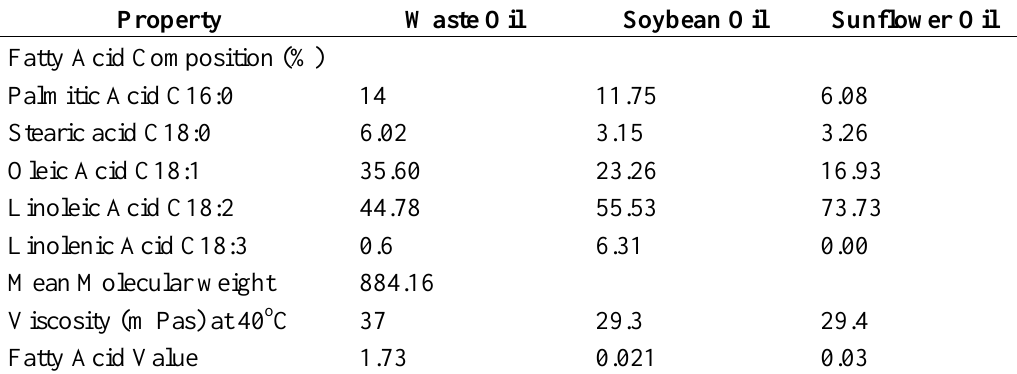
Table 1. Shows the chemical properties and fatty acid composition of the oil. Property Waste Oil Soybean Oil Sunflower